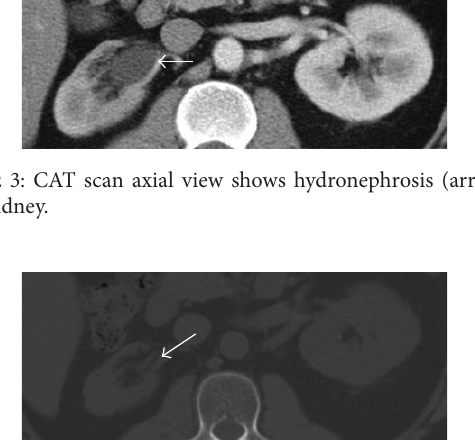
Figure 4: CAT scan axial view showed resolved hydronephrosis (arrow) in right